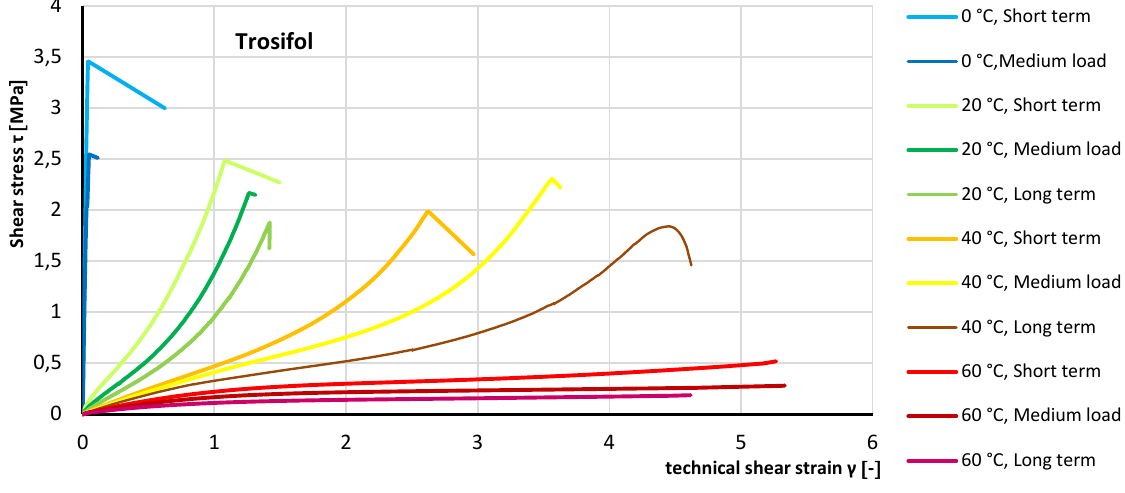
Fig. 8 Representative stress-strain curves for Trosifol